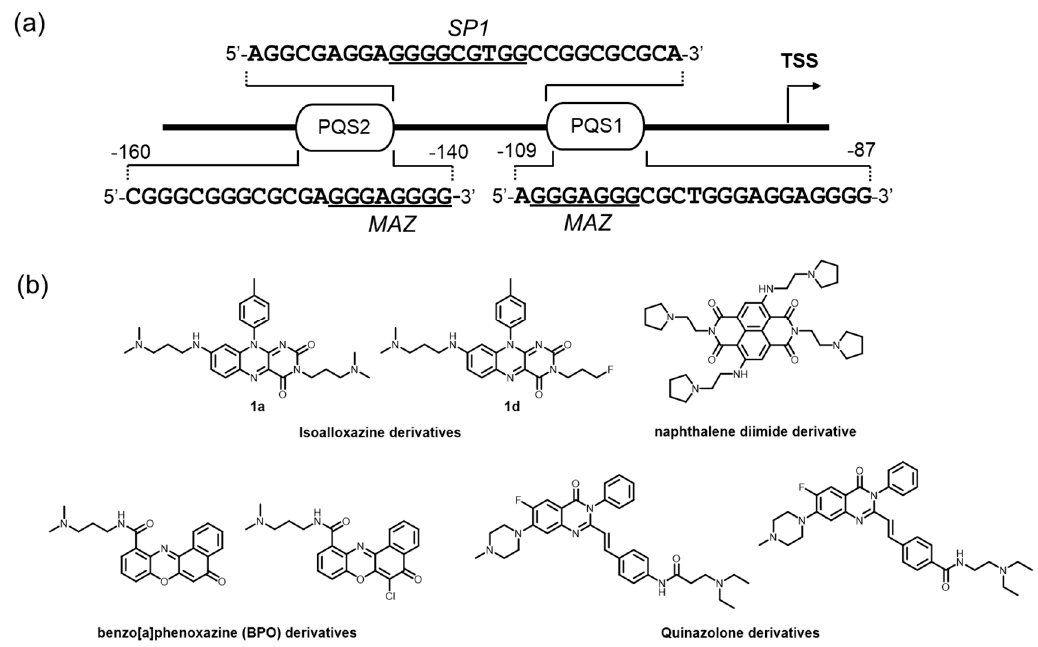
( b ) Molecules interacting with its G4 DNA and showing the downregulation of the c- kit